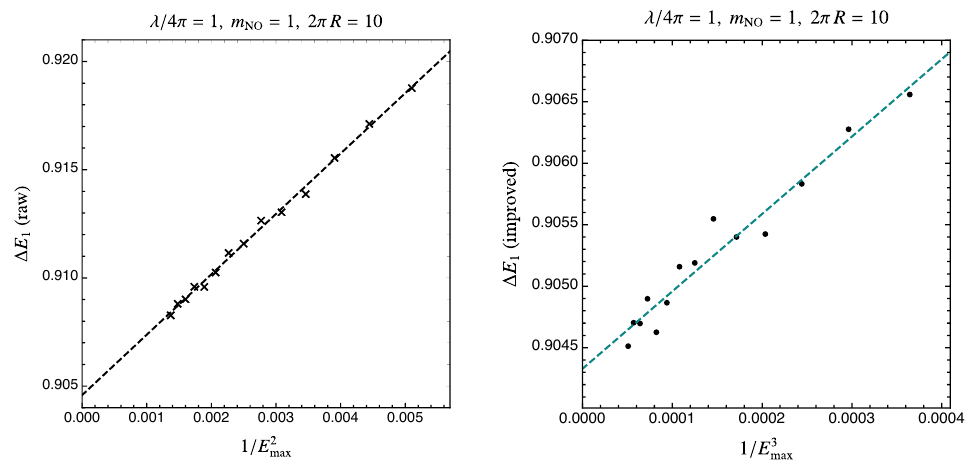
≥ 14 max as a function of 1 / E 2 for 1 max for the improved theory max extracted from the fits are in close agreement: 1 = 0.9043 1